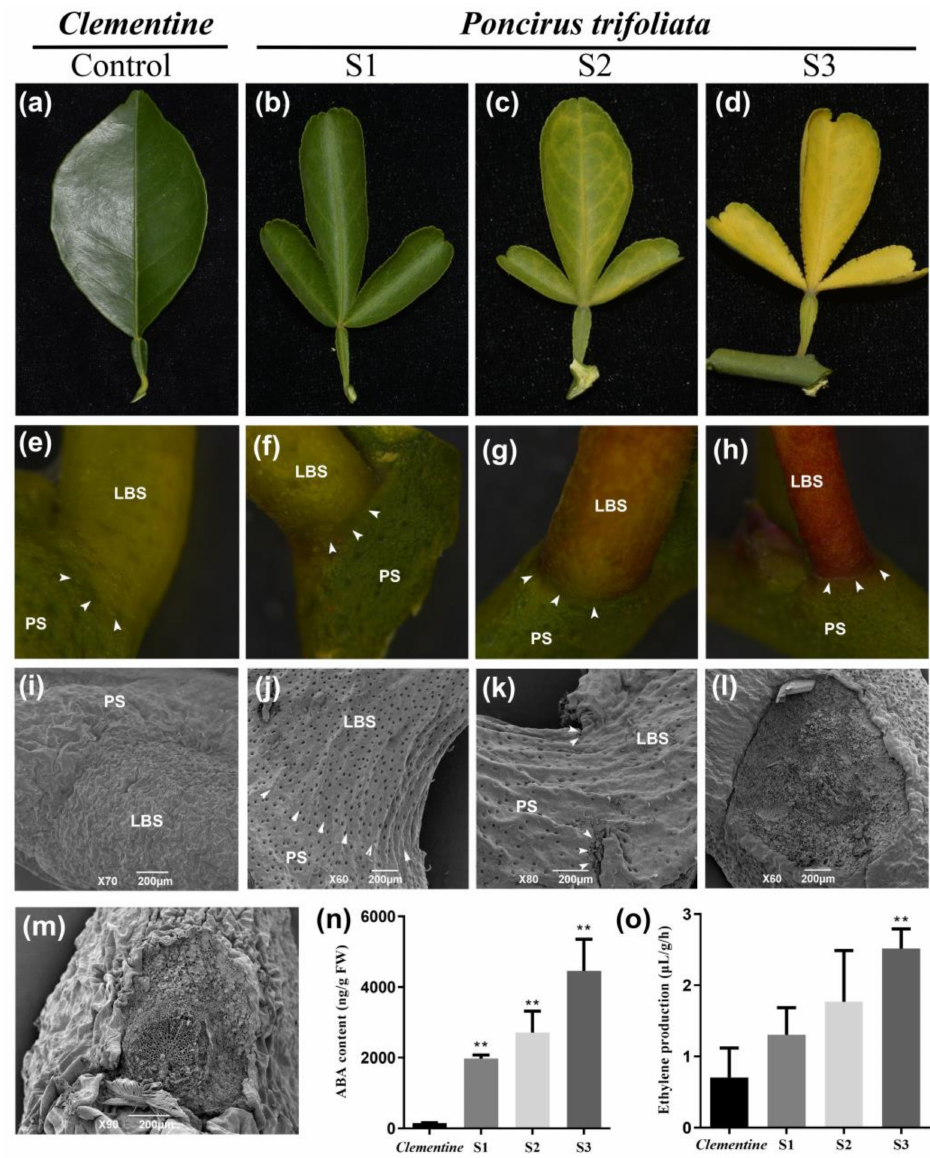
Figure 1. Morphological characterization of citrus leaf abscission and hormone quantification. ( a ) Phe- notypic characteristics of clementine mandarin leaves at stage 1 (before abscission). ( b – d ) Phenotypic characteristics of trifoliate orange leaves at stage 1 ( b ), stage 2 ( c ), and stage 3 ( d ). Stage 1: before abscission; stage 2: beginning of abscission; stage 3: after abscission. ( e – h ) Detailed characteris- tics of trifoliate orange leaf abscission zone at stage 1 ( f ), stage 2 ( g ), and stage 3 ( h ). ( i ) Cellular morphology of clementine mandarin leaf abscission zone at stage 1. ( j – l ) Cellular morphology of trifoliate orange leaf abscission zone at stage 1 ( j ), stage 2 ( k ), and stage 3 (petiole side, l ), respectively. ( m ) Cellular morphology of clementine mandarin leaf abscission zone (petiole side) after forcible separation. ( n ) Changes in ABA content (ng/g fresh weight) in leaf abscission zone of trifoliate orange. ( o ) Changes in ethylene ( µ L/g/h) in the leaf abscission zone of trifoliate orange. leaf blade side: LBS; petiole side: PS. The white arrow indicates location of the abscission zone. Asterisks indicate significant differences: ** p <